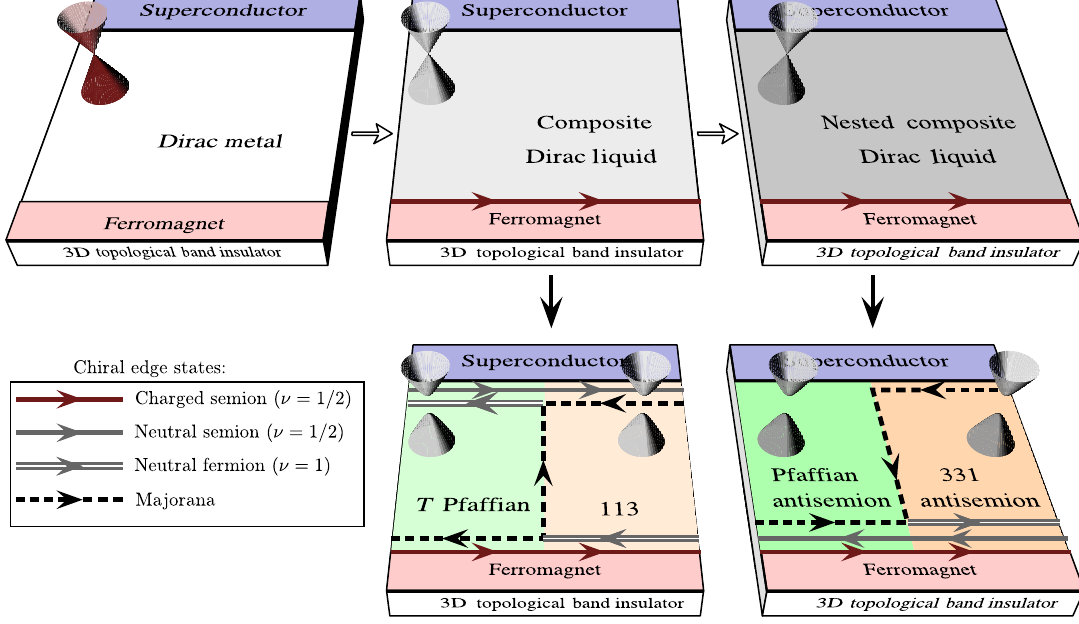
FIG. 1. Executive summary of results. Stripping the electric charge off of the original surface Dirac cone (top left) yields a composite Dirac liquid (top center) that exhibits a charge gap but features a gapless Dirac cone formed by electrically neutral fermions. Analogously stripping a fictitious pseudocharge from the latter yields a nested composite Dirac liquid (top right) with a second- generation neutral Dirac cone. These composite Dirac liquids serve as parent states for topologically ordered surface phases (bottom row) obtained by gapping the neutral Dirac cones with pairing or magnetism. Importantly, pairing proceeds without breaking electric charge conservation — because the paired fermions are neutral — and hence produces symmetric surface topological orders captured by previous works [13 –